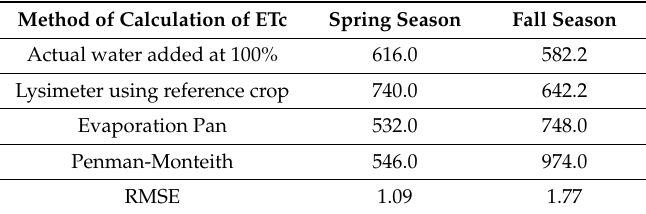
Table 5. Means of total irrigation water added per season of potato crop during the lysimeter experiments